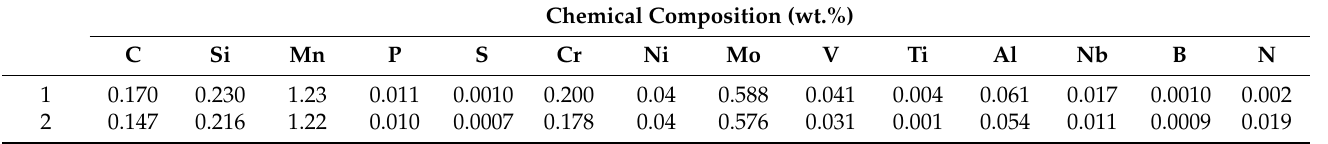
Table 1. Chemical composition of the investigated S960QL steel in wt%.